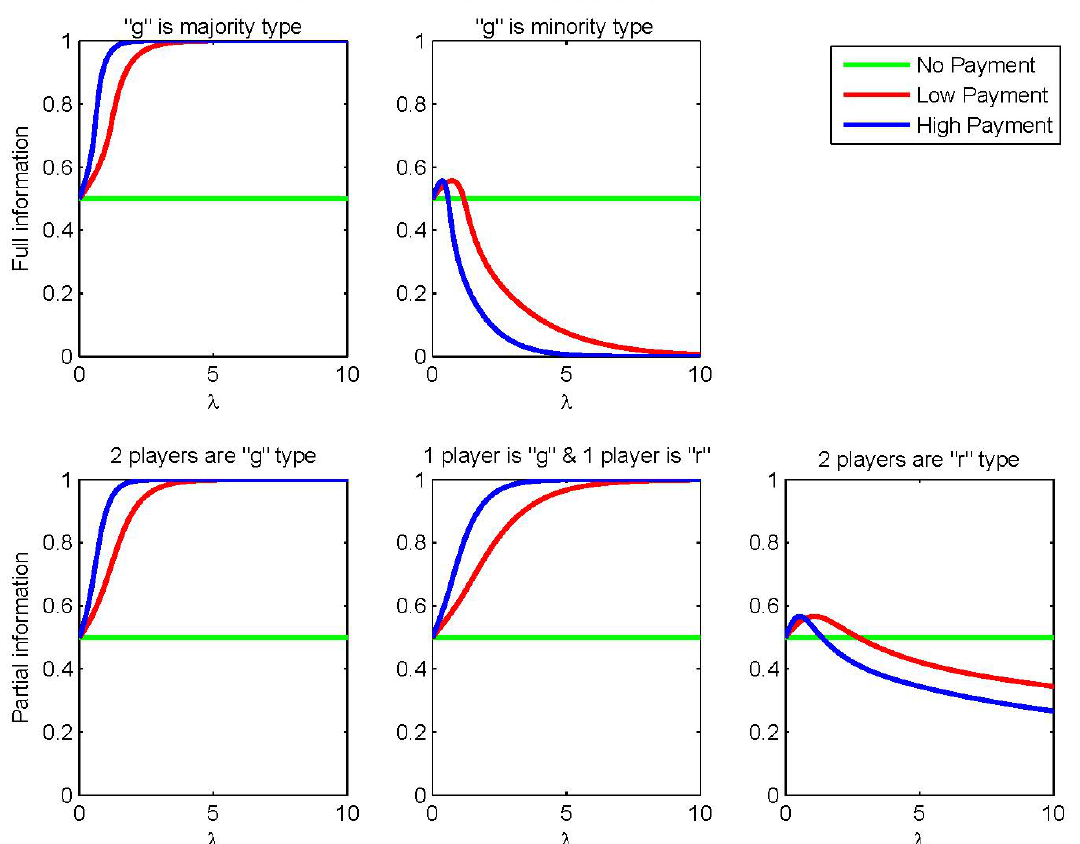
Figure 1. Probability that a “g” type player votes for